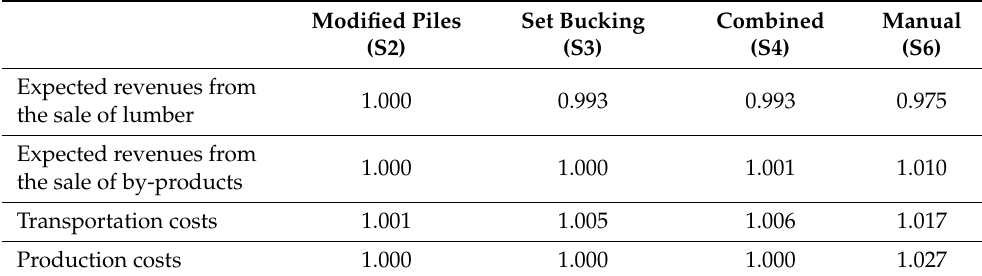
Table 4. Revenues and costs variations for selected scenarios in comparison to the optimal scenario (set at